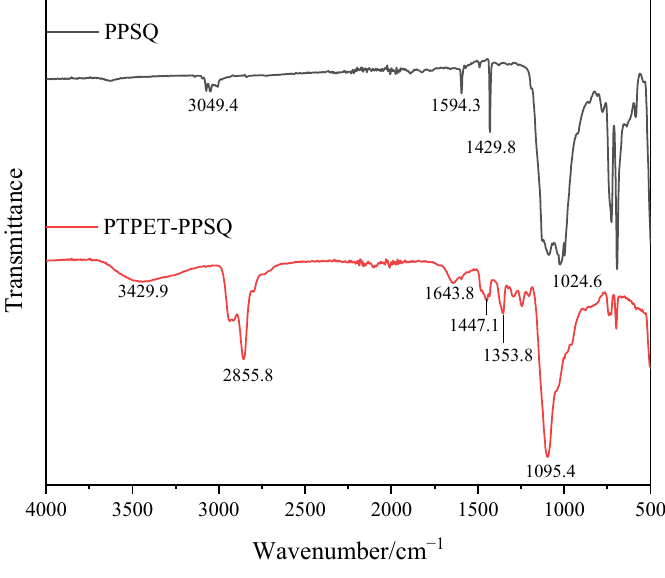
Figure 7. FT-IR analysis of PTPET-PPSQ.